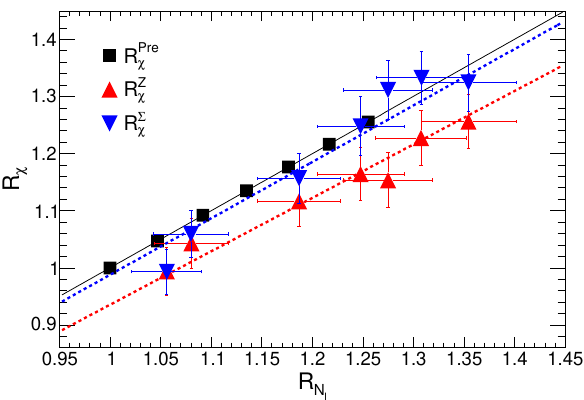
and R (cid:6) with the prediction R Pre . The (cid:31) (cid:31) , and R (cid:6) , (cid:31) (cid:31)